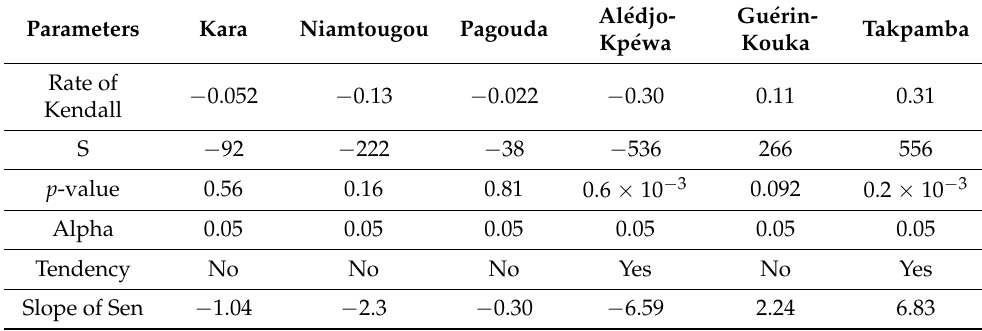
Table 3. Results of the Mann–Kendall and Sen tests.